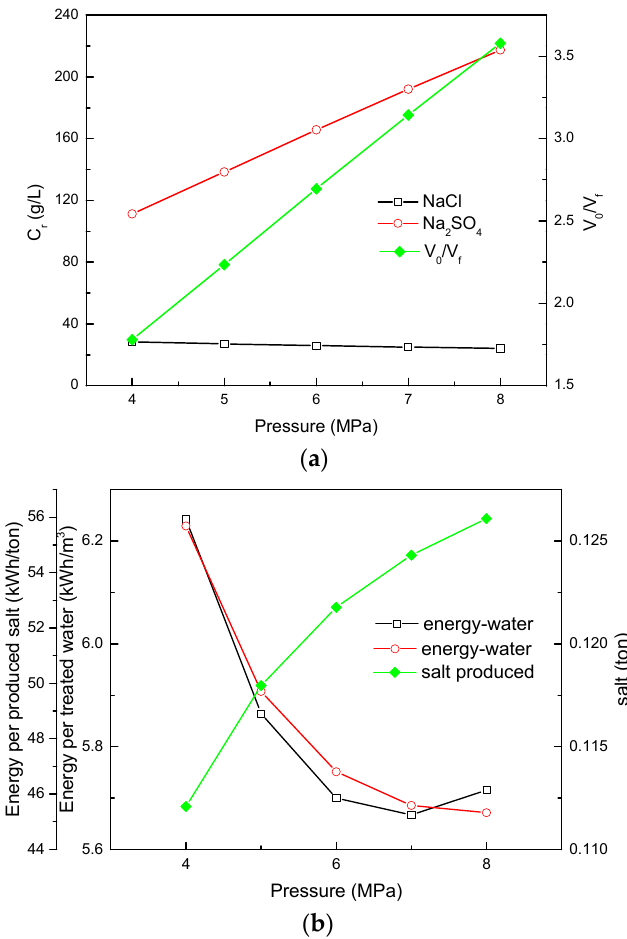
Figure 8. ( a ) Salt concentration in the retentate and V 0 /V f ; ( b ) E water , E salt and salt production as a function of operating pressure.